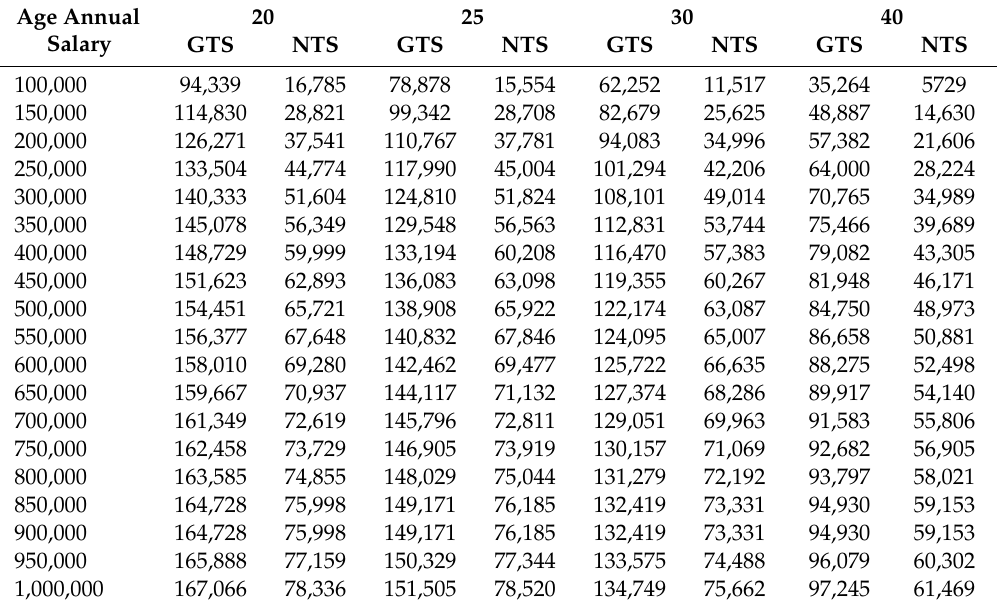
Table 1. The GTS and NTS of di ff erent initial insured annual salaries for men under di ff erent initial insured ages. (unit: